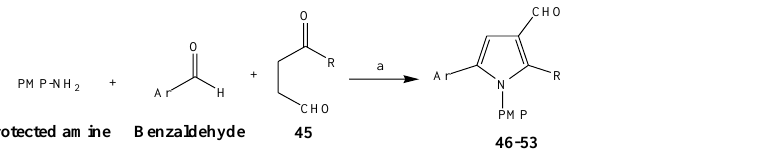
A ce t o ph e n o n e T h i o u re a a = EtOH/Reflux, b = EtOH/Reflux. Scheme 3. Synthetic route of compound 44.